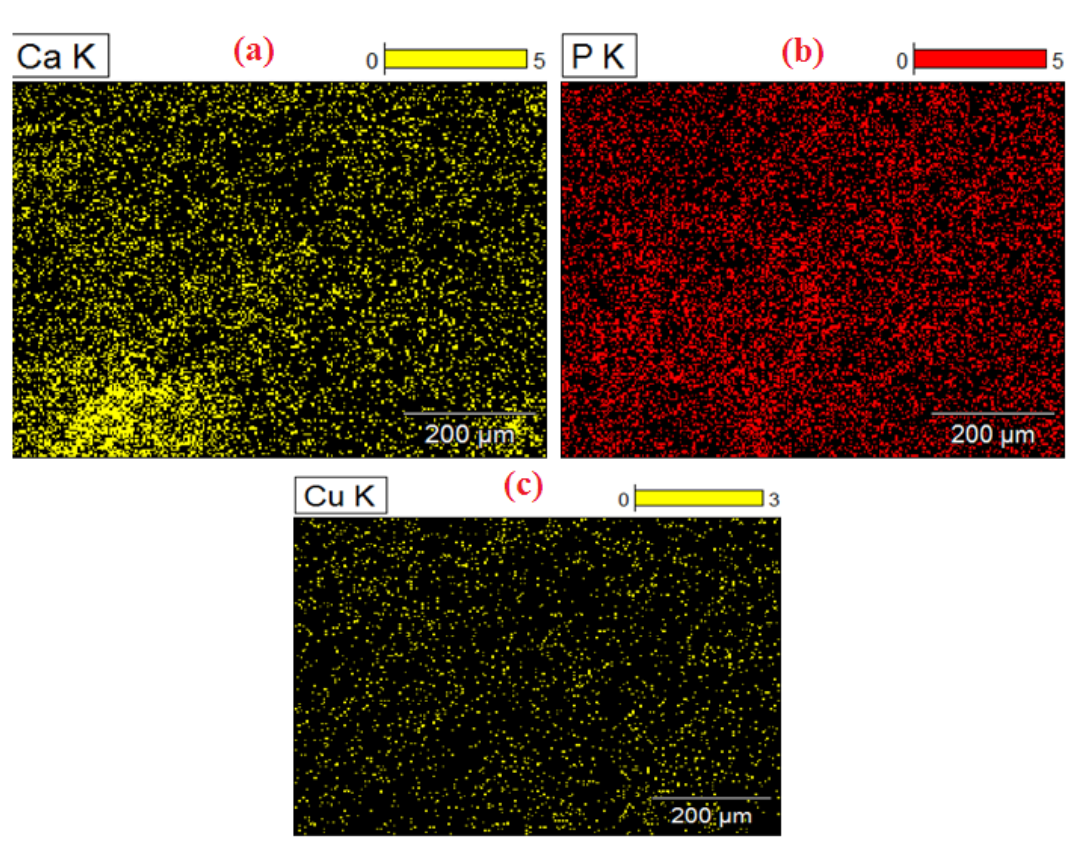
Figure 5. EDS: elemental mapping ( a ) Copper ( b ) Phosphorus ( c ) Calcium Table 2. Chemical composition of Zn-Ti-Cu-Ca-P alloy by EDS.